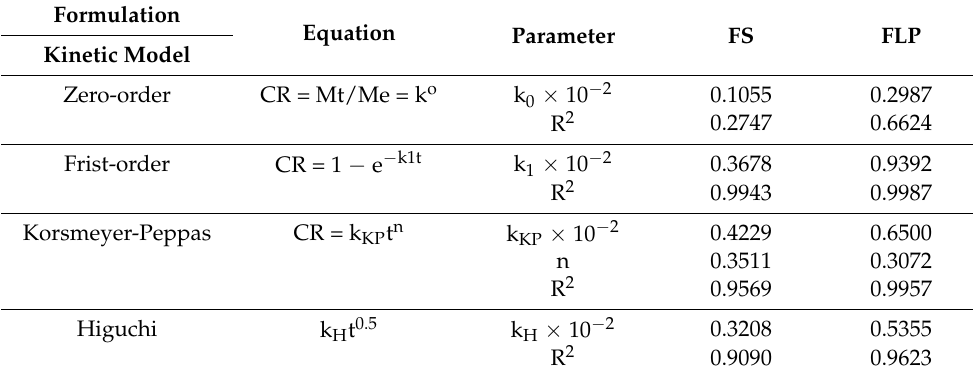
Figure 3. The 3-D surface response plots demonstrate the effect of FN concentration, total lipid content, and cholesterol proportion in total lipid on the vesicle size ( A – C ), % Entrapment efficiency ( D – F ), and % Drug loading capacity ( G – I ) of FLP. Table 4. The kinetic release behaviors of FS and FLP.